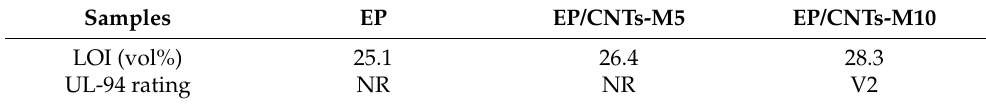
Table 4. The limiting oxygen index (LOI) and UL-94 rating of EP and composites EP/CNTs-M. Samples